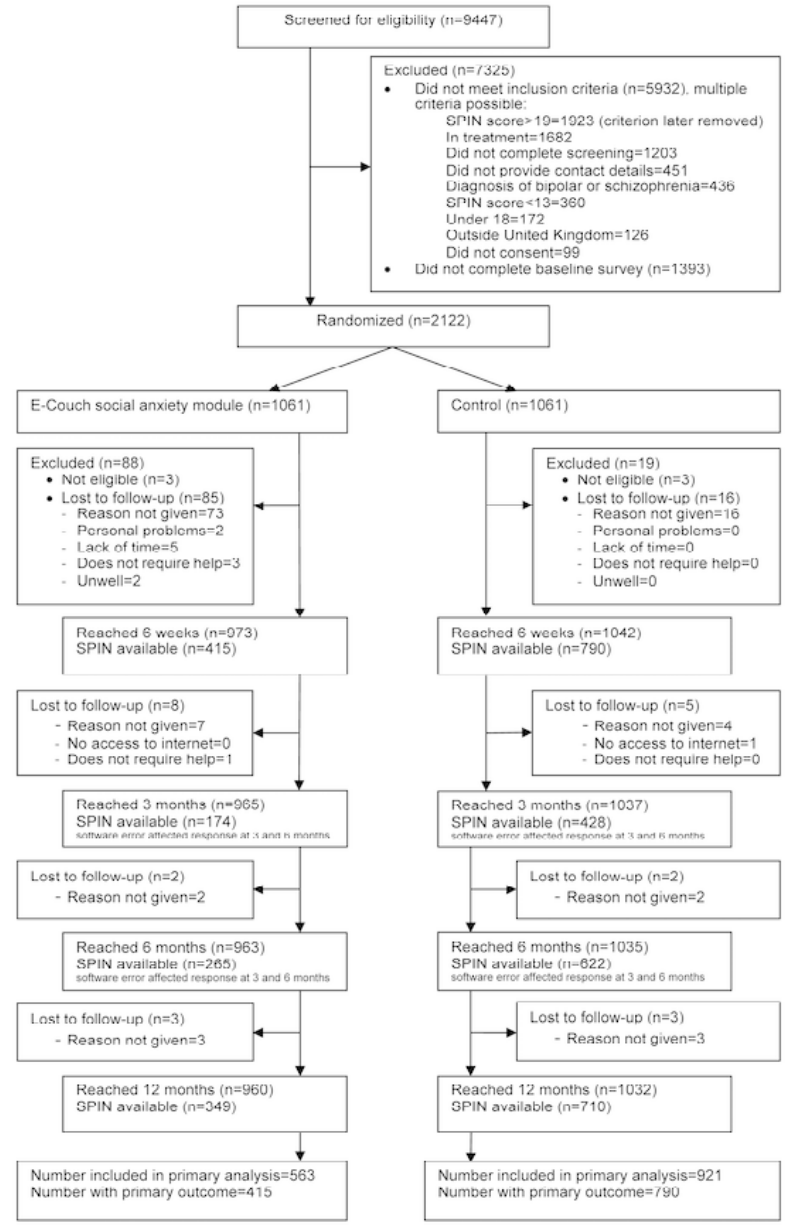
Figure 1. Consolidated Standards of Reporting Trials flow